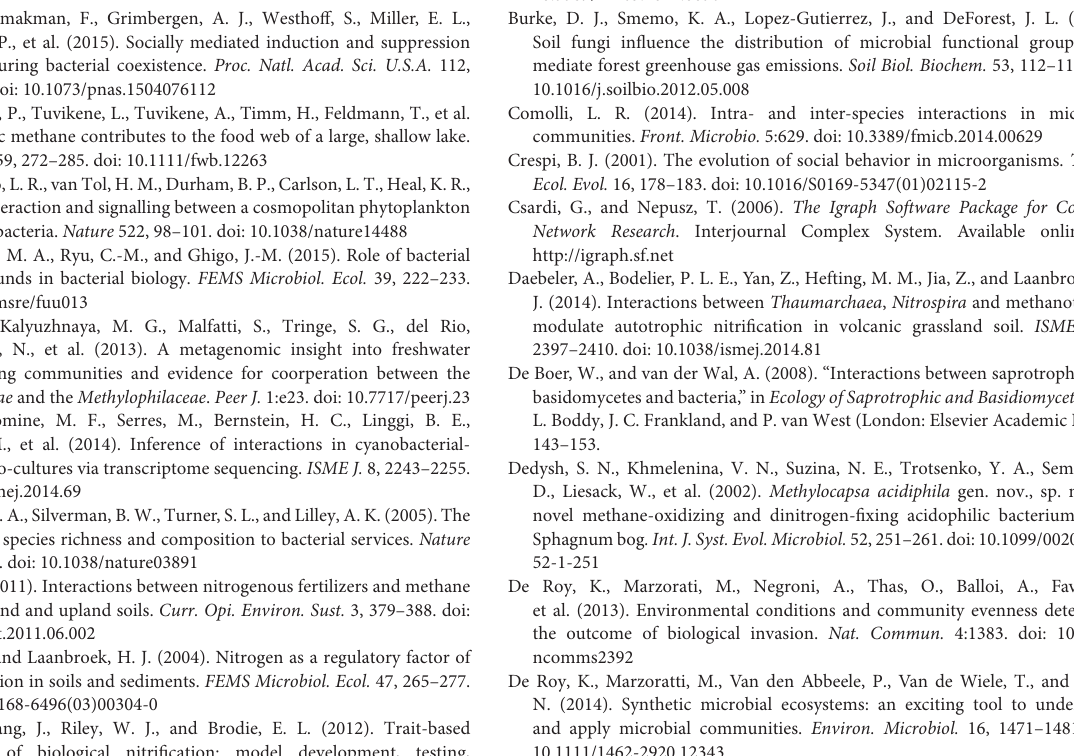
Figure S4 | Network analysis of 16s rRNA gene sequences derived from the “heavy” fraction of a 13 C-CH 4 labeled community in a rice paddy soil (Zheng et al., 2014). The correlating OTUs with >1% relative abundance are given in the figure, and the corresponding taxonomic affiliation are listed in the Supplementary Information ( Table S4 ). Figure S5 | Network analysis of 16s rRNA gene sequences derived from the “heavy” fraction of a 13 C-CH 4 labeled community in sediments from oilsands tailings ponds (Saidi-Mehrabad et al., 2013). The correlating OTUs with >1% relative abundance are given in the figure, and the corresponding taxonomic affiliation are listed in the Supplementary Information ( Table S5 ). Table S1 | Co-occurring OTUs with >1% relative abundance derived from the “heavy” fraction of a 13 C-CH 4 labeled community in sediments from geothermal springs. Classification of OTUs is as given in Sharp et al. (2014). Bold and gray scripts denote MOB and methylotroph, respectively. Table S2 | Co-occurring OTUs with >1% relative abundance derived from the “heavy” fraction of a 13 C-CH 4 labeled community in sediments from an arctic lake. Classification of OTUs is as given in He et al. (2012a,b,c). Bold and gray scripts denote MOB and methylotroph, respectively. Table S3 | Co-occurring OTUs with >1% relative abundance derived from the “heavy” fraction of a 13 C-CH 4 labeled community in a grassland soil. Classification of OTUs is as given in Daebeler et al. (2014). Bold and gray scripts denote MOB and methylotroph, respectively. Table S4 | Co-occurring OTUs with >1% relative abundance derived from the “heavy” fraction of a 13 C-CH 4 labeled community in a rice paddy soil. Classification of OTUs is as given in Zheng et al. (2014). Bold and gray scripts denote MOB and methylotroph, respectively Table S5 | Co-occurring OTUs with >1% relative abundance derived from the “heavy” fraction of a 13 C-CH 4 labeled community in oilsands tailings ponds. Classification of OTUs is as given in Saidi-Mehrabad et al. (2013). Bold and gray scripts denote MOB and methanol-oxidizer,